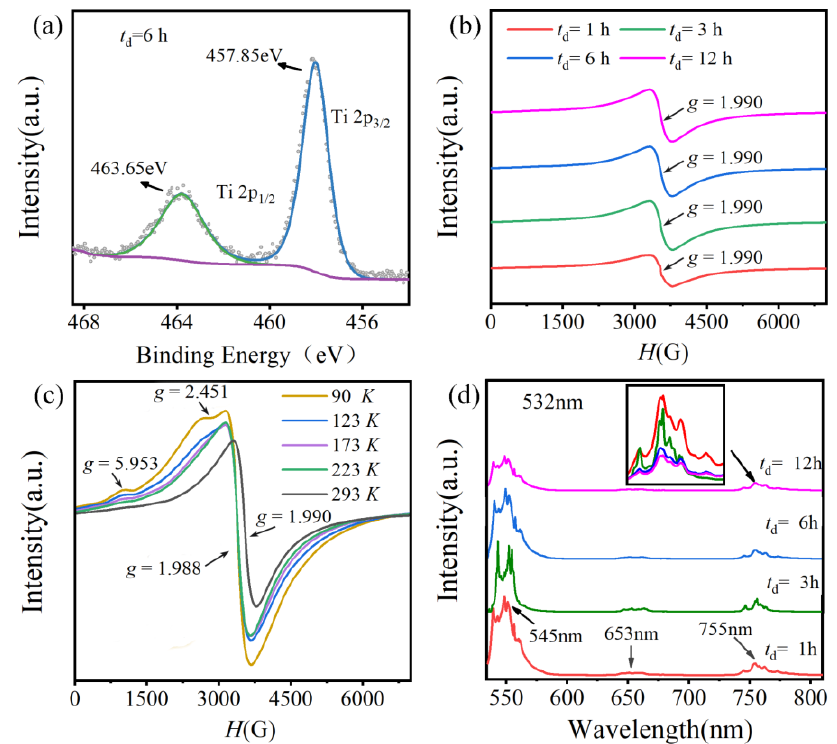
Figure 4. ( a ) Ti 2p XPS spectrum of BGTH7 sintered at T s = 1400 °C for 6 h. ( b ) EPR spectra of BGTH7 sintered at T s = 1400 °C measured at room temperature. ( c ) Temperature-dependent EPR spectra of BGTH7 sintered at T s = 1400 °C for 6 h. ( d ) Raman spectra under 532 nm excitation of BGTH7 ceramics sintered at T s = 1400 °C for 1, 3, 6 and 12 h.